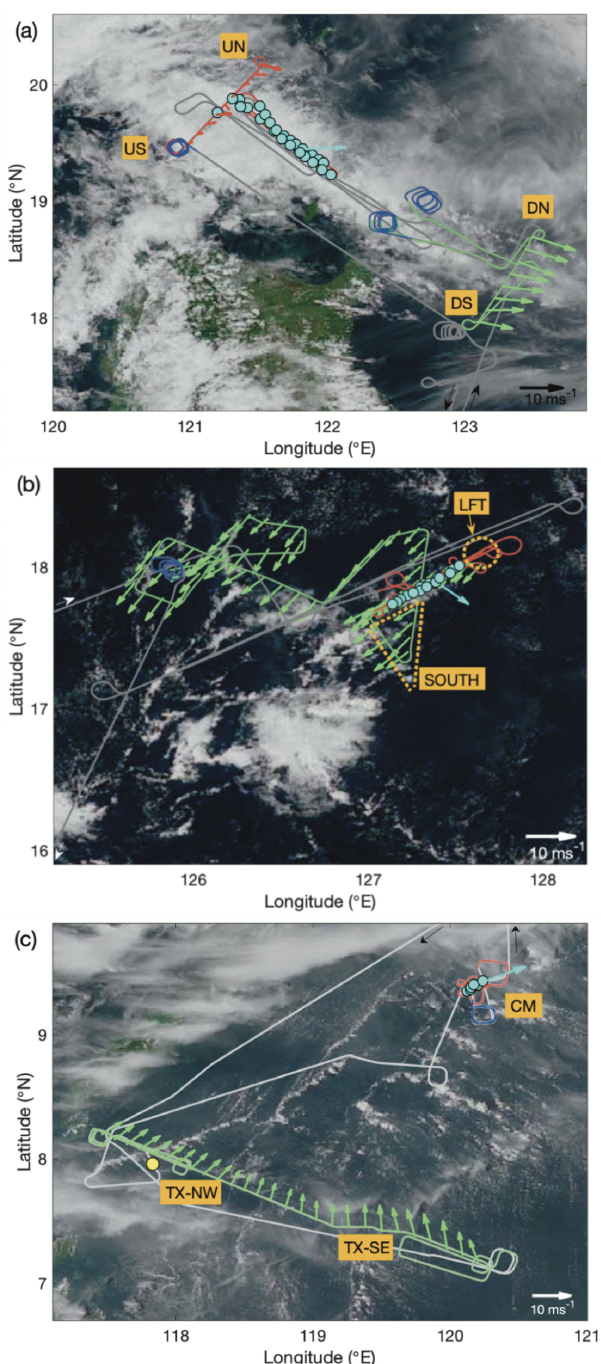
Figure 2. Flight tracks (grey) overlaid on visible satellite imagery from the Advanced Himawari Imager (accessed through the CAMP2Ex Worldview Interface: http://geoworldview.ssec.wisc.edu, last access: 9 February 2021) taken near the time of cloud sampling for (a) Case I: 19–20 September 2019, (b) Case II: 23–24 September 2019 and (c) Case III: 15–16 September 2019. Green highlights correspond to periods of extended low-altitude sampling that were used for characterization of the sub-cloud layer structure, trace gases, and aerosols. Red highlights correspond to the cloud modules: in panels (a) and (b) these were “wall” patterns with extended level legs at multiple altitudes within, and near to, cloud. In panel (c) this was a spiral descent with multiple penetrations of cloud at different altitudes. Nearby spiral profiles are highlighted in blue. Cloud water (CW) samples are indicated by cyan-filled circles and in panel (c) an auxiliary CW sample in yellow. Low-level (green, red) and near-cloud-top (cyan) wind vectors are shown using 60s and leg-mean horizontal wind data, respectively. Designated air-mass locations are shown (see text for